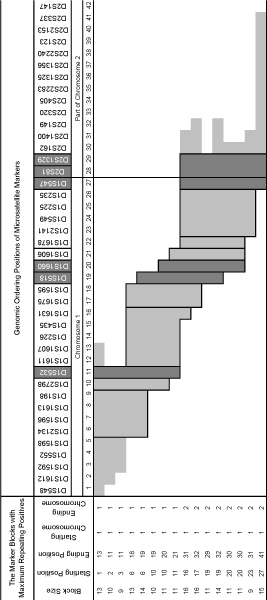
Results of microsatellite markers pattern/association with ALDX with maximum (4) repeating positives from SVM analysis using 4 different kernels.